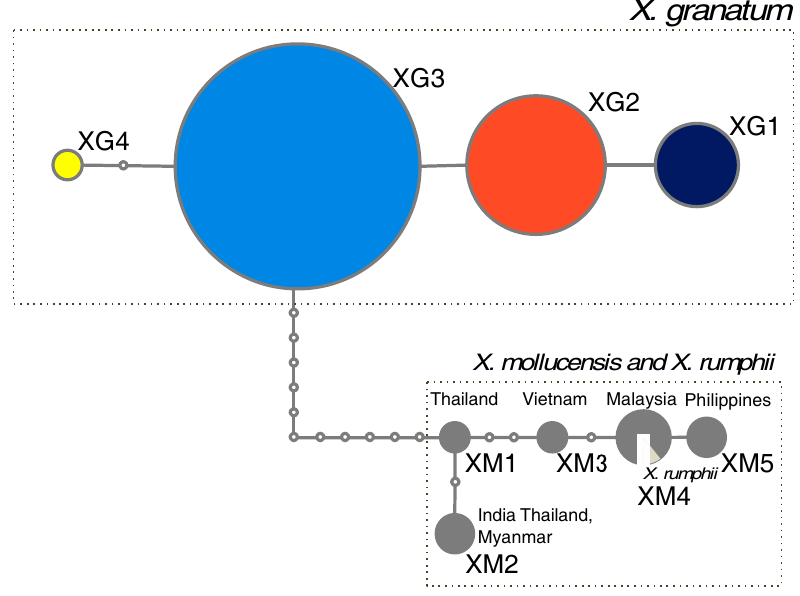
Figure 2. A statistical parsimony network constructed using the concatenated cpDNA sequences used in this study. XG1–4 designate the haplotypes of Xylocarpus granatum J. Koenig and XM1–5 of Xylocarpus moluccensis M.Roem. XM4 was also possessed by Xylocarpus rumphii (Kostel.) Mabb.